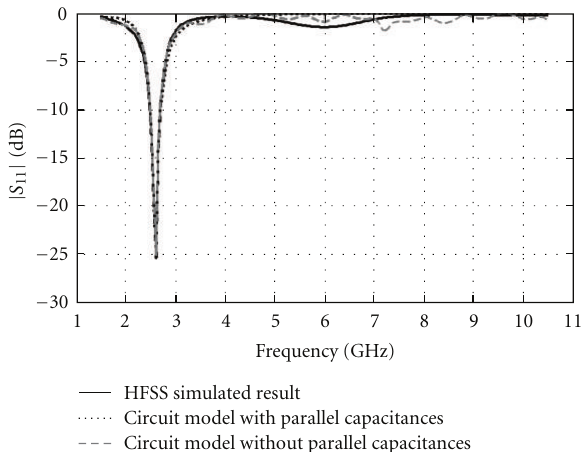
Figure 6: Reflection coe ffi cients of equivalent circuit model of the harmonic suppression